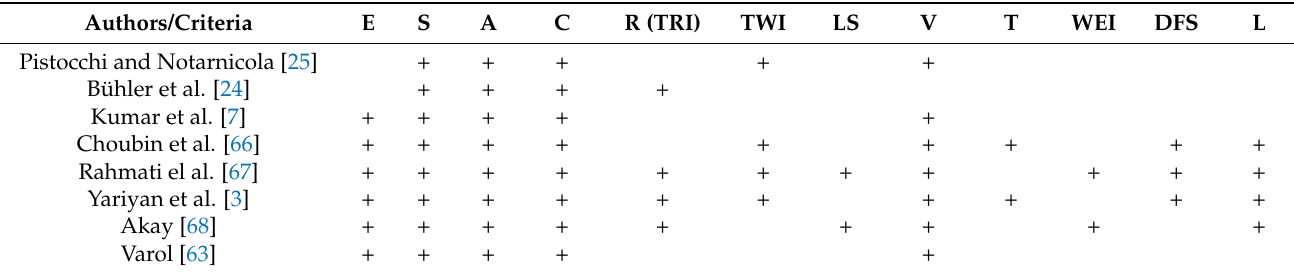
Table 3. Authors of articles and criteria